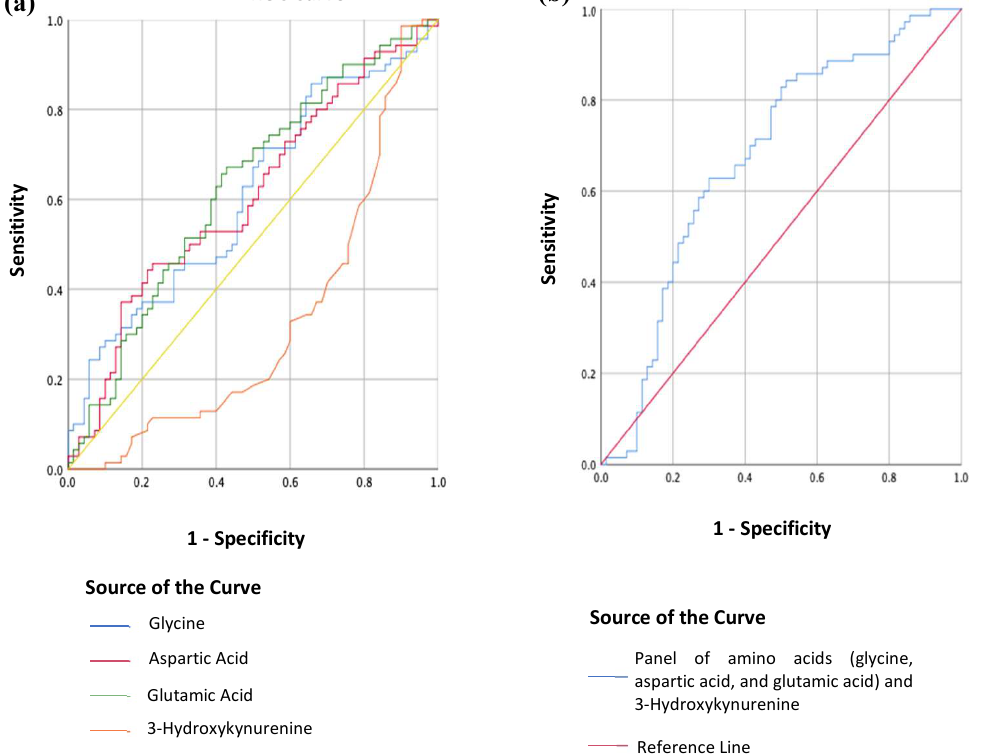
Figure 3. ( a ) Receiver operating curve (ROC) analysis of the individual metabolites’ concentrations in blood serum between MDD patients (n = 70) and HCs (n = 70); ( b ) Receiver operating curve (ROC) analysis of a combination of glycine, aspartic acid, glutamic acid, and 3-Hydroxykynurenine concentrations in blood serum between MDD patients (n = 70) and HCs (n = 70). However, using a combination of glycine, aspartic acid, glutamic acid, and 3-Hydroxy- kynurenine concentrations in blood serum, patients with MDD could be discriminated from HCs with enhanced accuracy (see Figure 3b). The AUC was 0.68 [95% CI, (0.59, 0.77)], and an optimal threshold value of 0.51 correctly classified 65.7% of MDD patients (proportion of pa- tients/measurements: 47/70) and 62.9% of HCs (proportion of controls/measurements: 44/70; PPV = 0.64; NPV =